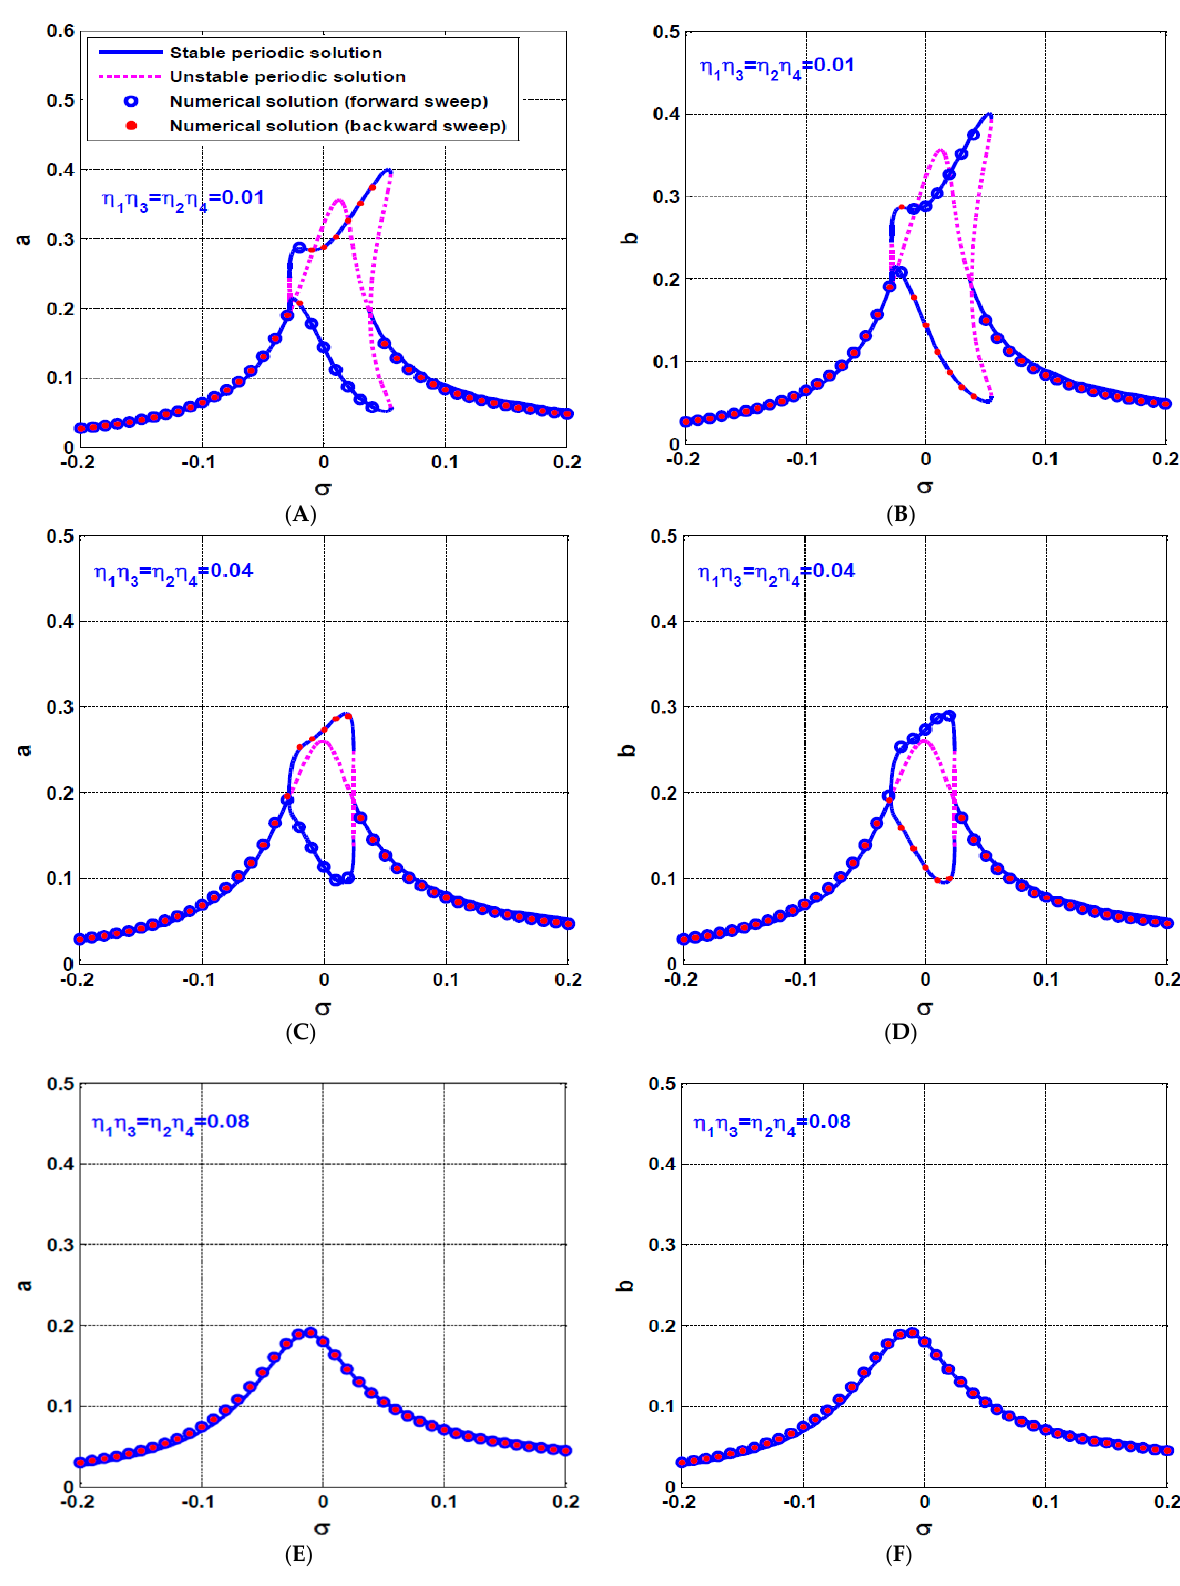
Figure 14. The rotor system σ response curve at three different values of the product of the control signal gain ( η 1 , η 2 ) and feedback signal gain ( η 3 , η 4 ) of the IRCs: ( A , B ) the system oscillation amplitudes a and b when η 1 η 3 = η 2 η 4 = 0.01, ( C , D ) the system oscillation amplitudes a and b when η 1 η 3 = η 2 η 4 = 0.04, and ( E , F ) the system oscillation amplitudes a and b when η 1 η 3 = η 2 η 4 =